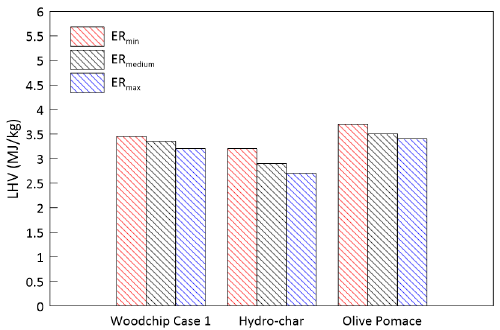
Figure 12. Syngas LHV (on a daf basis) at different ER for woodchip case 1, hydro-char from green waste, olive pomace.